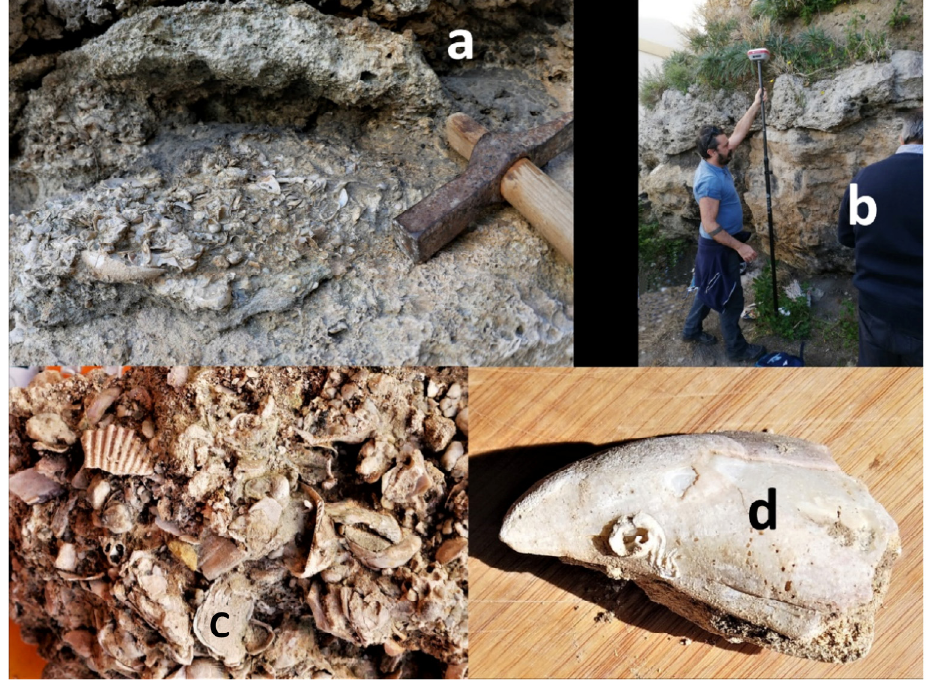
Figure 5. The Cannitello 4 and 1 outcrops. ( a – c ) The size and some details of the section. ( d ) A particular of Mytilus of Cannitello